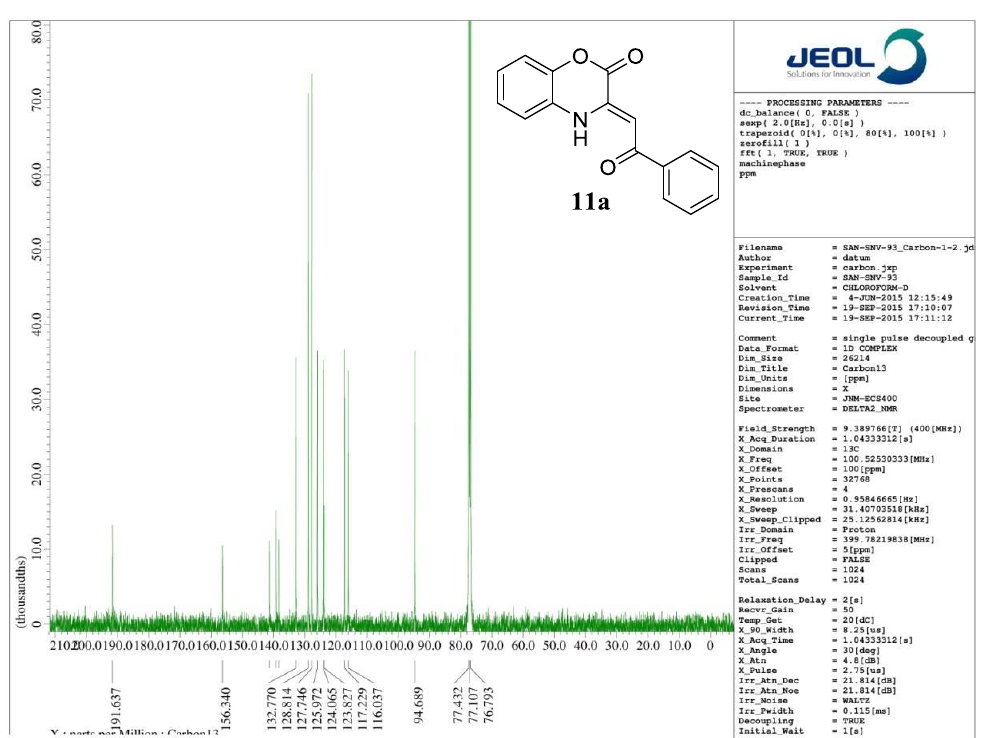
Figure 1. 1 H NMR Spectra of Compound 11a .